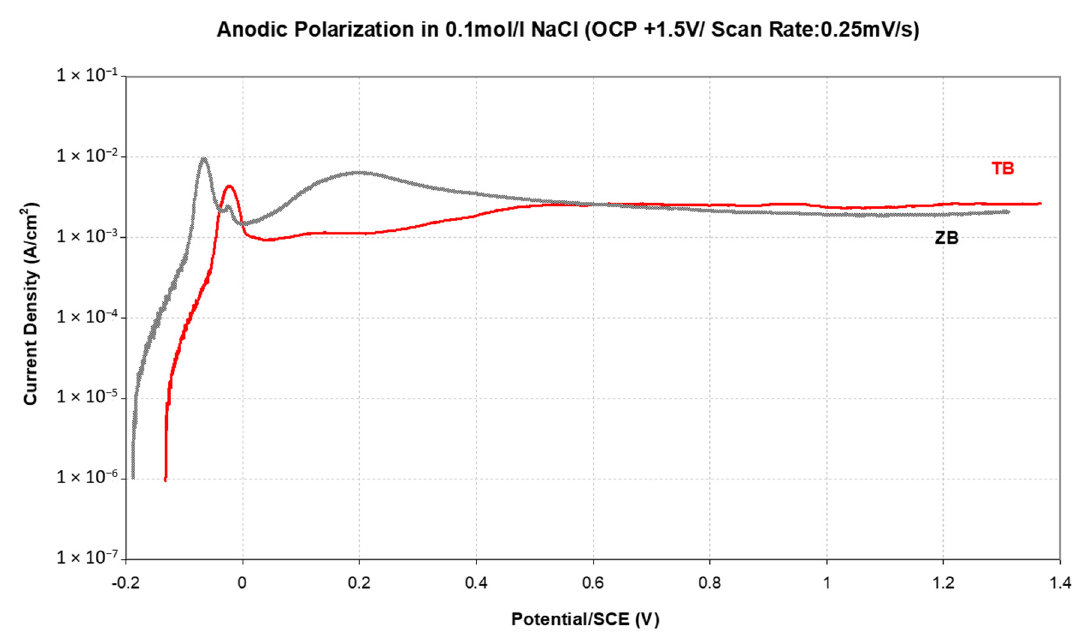
Figure 8. Anodic polarization curves of TB and ZB (OCP+ 1.5 V) acquired in 0.1 mol/L NaCl at a slow scan rate of 0.25 mV/s, after 30 min at OCP conditions. ZB curve was first presented in [29].